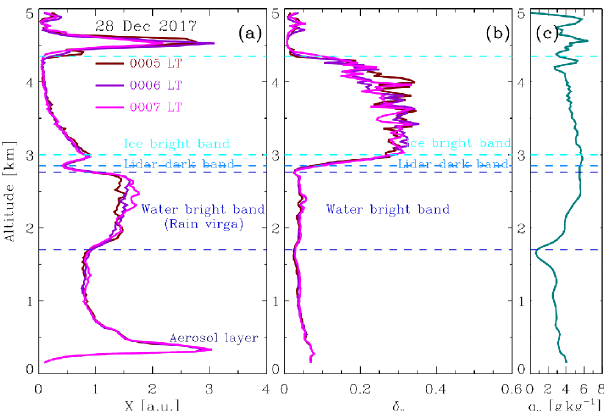
Figure 6. Lidar profiles for a virga and its apparent source cloud occurring between intermittent reaching-surface precipita- tions. (a) Range-corrected 355nm signal X profiles from 00:05 to 00:07LT on 28 December 2017; (b) 355nm volume depolarization ratio δ v profiles in the same period and (c) 1h averaged lidar q v profile centered at 00:06LT on the same